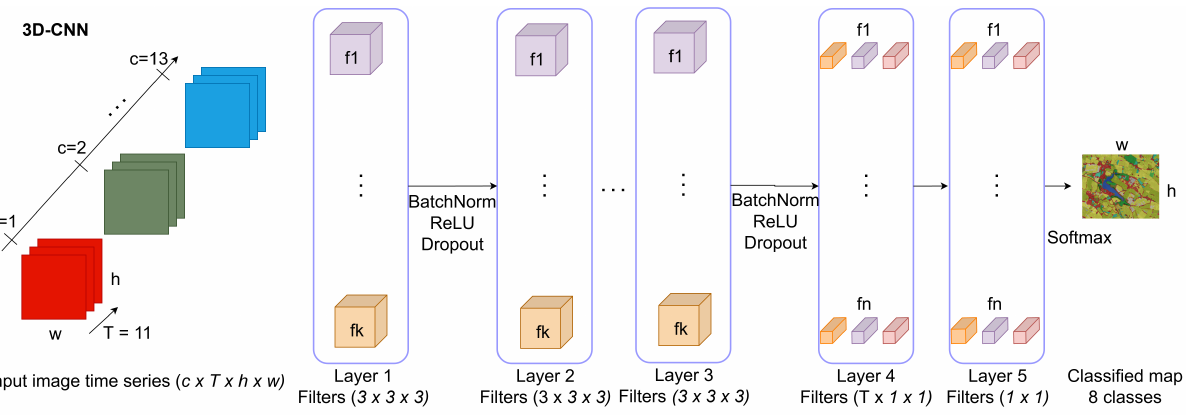
Figure 5. 3D-CNN model.